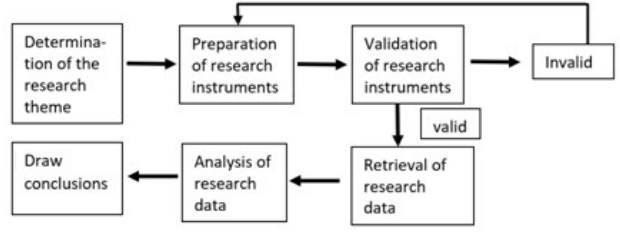
Figure 1. Research flow